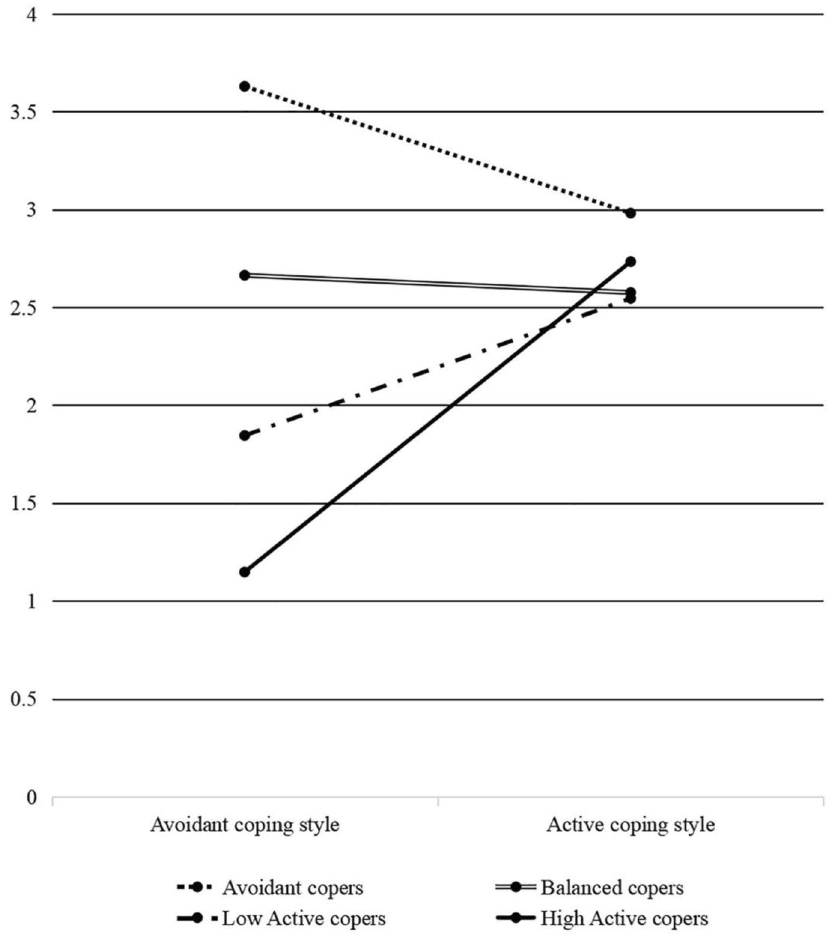
Figure 1. Means scores of active and avoidant coping styles in the four coping profiles.